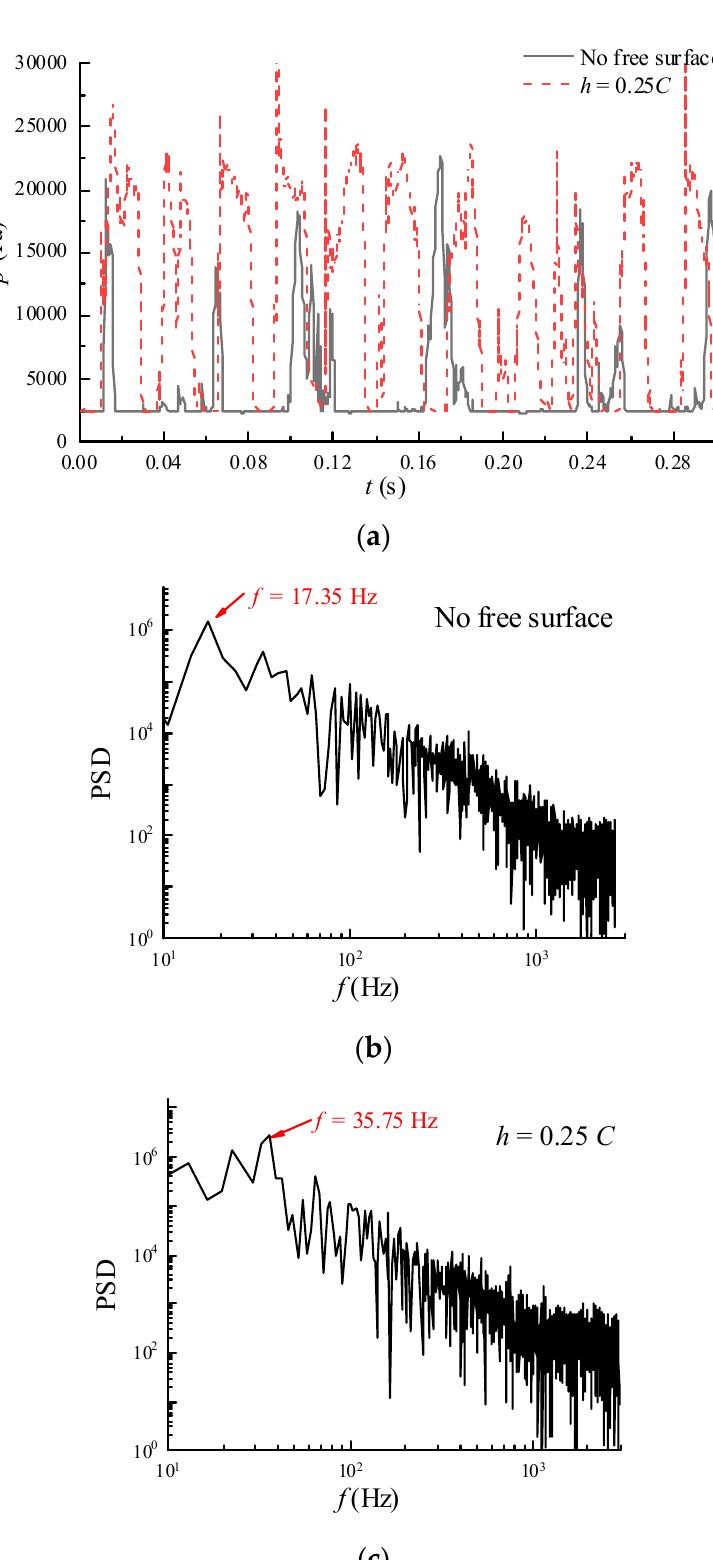
Figure 9. Pressure fluctuations and the corresponding PSD at P3. ( a ) Pressure fluctuation on the suction surface of the hydrofoil at P3; ( b ) PSD of the pressure fluctuation at P3 for the no free surface case; ( c ) PSD of pressure fluctuation at P3 for the near free surface case.